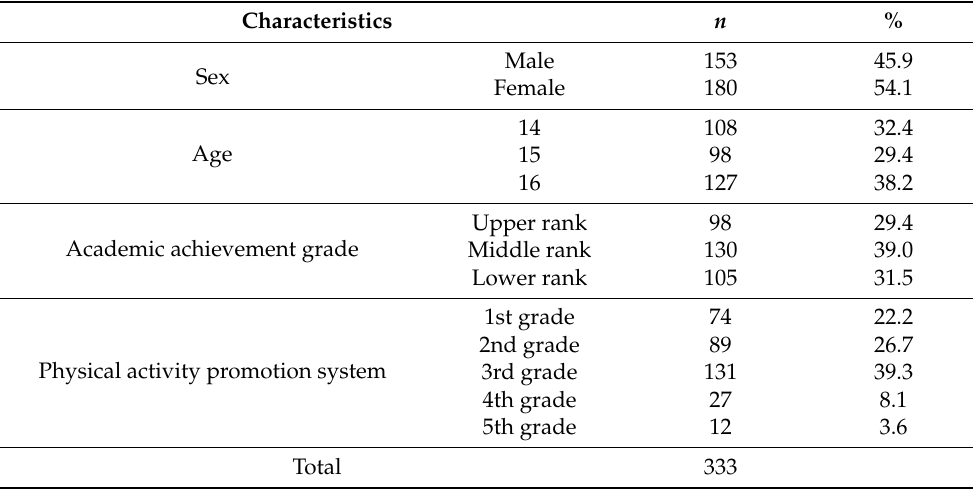
Table 1. Demographic characteristics of the